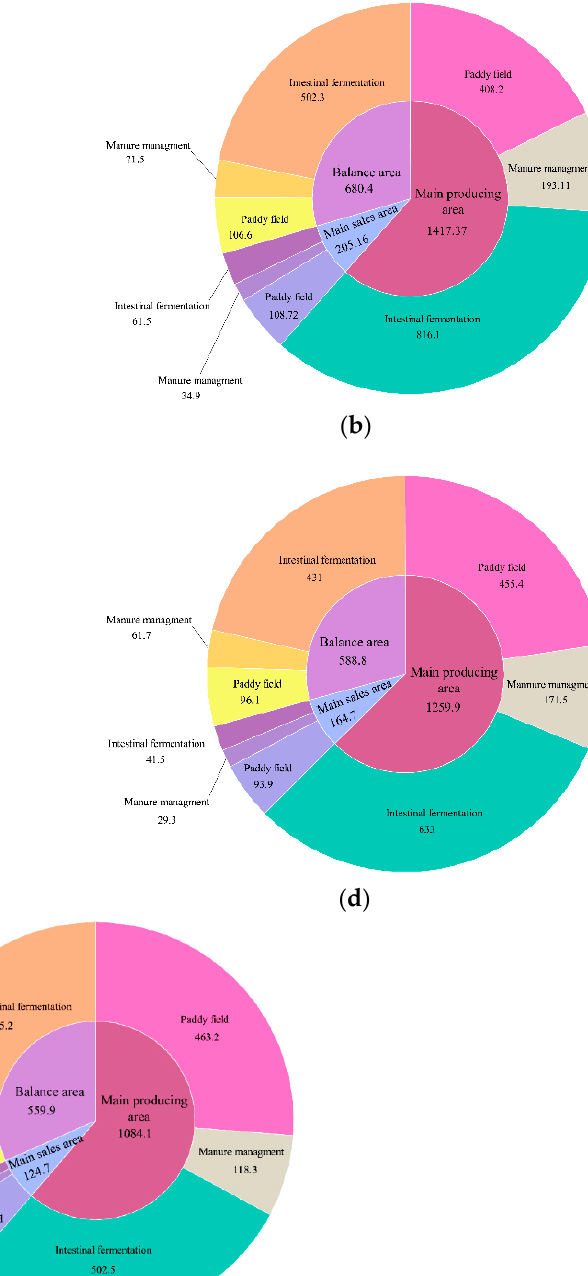
the past 20 years, with an average annual decline of 0.83%, of which 2000–2005 and 2010– 2015 were the rising periods, with increases of 10.78% and 2.34%, respectively; 2005–2010 and 2015–2019 were the decreasing periods, and the decline was relatively large, with 13.14% and 13.96%, respectively. Although the total amount of emissions had a down- ward trend, the discharge of paddy fields had an upward trend, and the proportion of emissions was also different from the total amount of emissions. 2000–2005 and 2015–2019 were decreasing periods, 2005–2015 was the rising period, where the total amount in- creased from 4.0507 million tons in 2000 to 4.6324 million tons in 2019, and the proportion of emissions increased from 31.66% to 42.73%. Manure management emissions and intes- tinal fermentation emissions were on a downward trend, decreasing by approximately 30.02% and 28.75%, respectively. In short, the emission structure of the main producing areas was optimized, where livestock and poultry intestinal emissions were the main source of emissions; the proportion of paddy field emissions and intestinal emissions was close, with 42.73% and 46.36%, respectively in 2019. Paddy field management will con- tinue to be an important measure to reduce emissions in major producing areas. Agricul- tural methane emissions from the main sales areas were the lowest, and although the ag- ricultural methane emissions from paddy fields were not the highest among the three